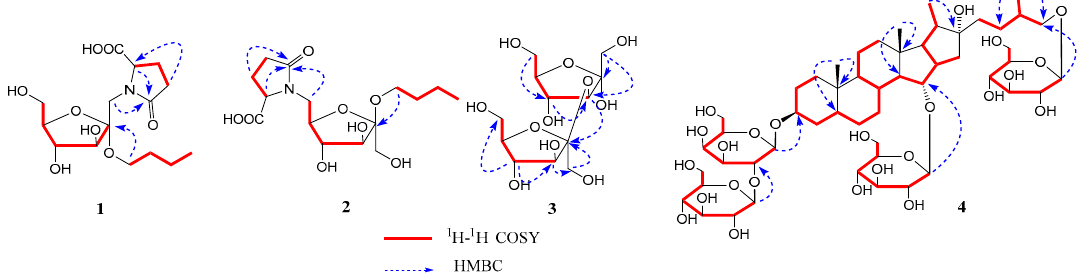
Figure 2. Key heteronuclear multiple bond correlation (HMBC) and 1 H- 1 H correlation spectroscopy (COSY) correlations of compounds 1 – 4 .